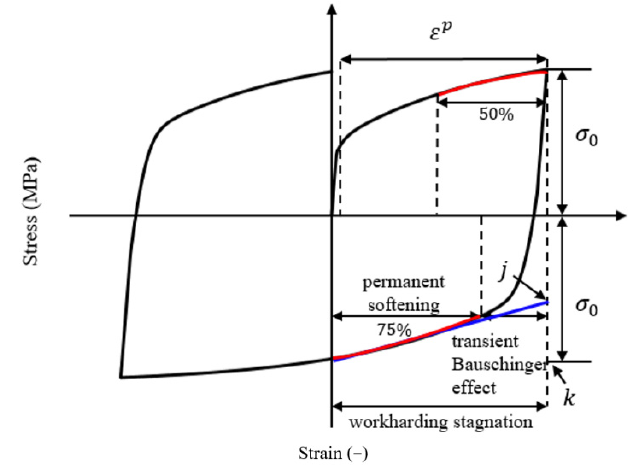
Figure 3. Stress-strain curve under cyclic deformation.